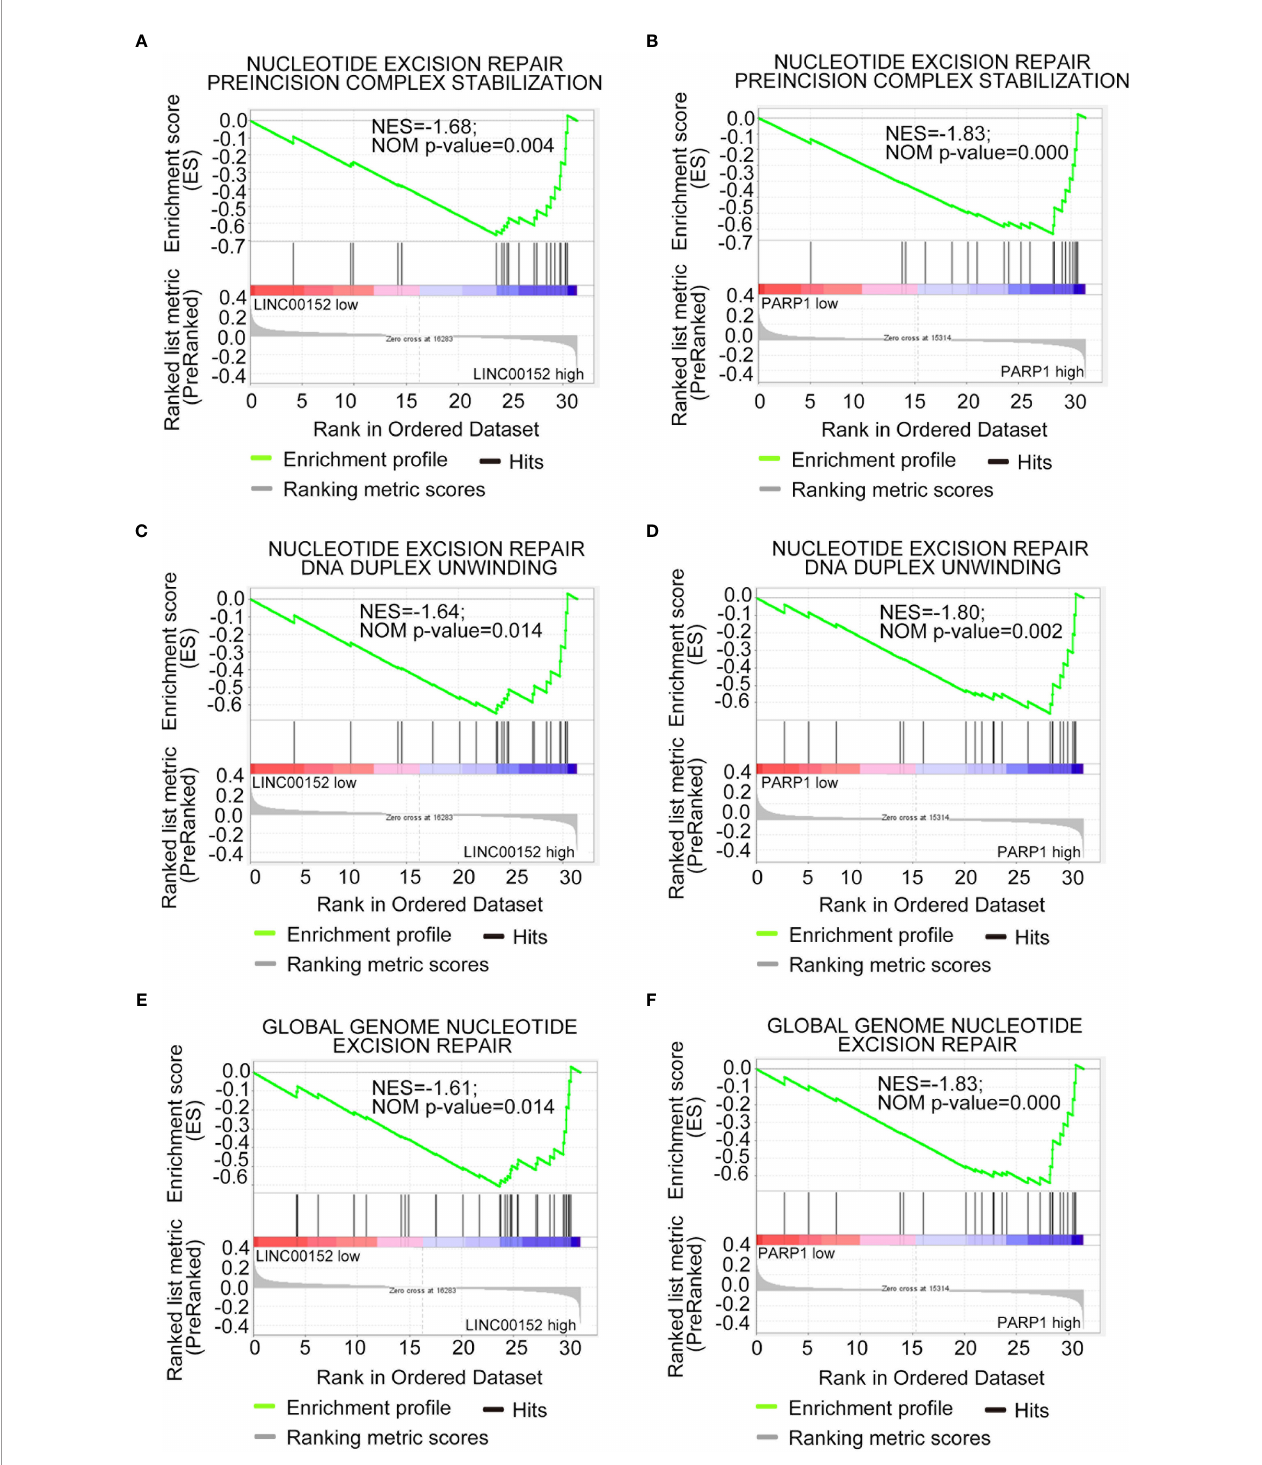
FIGURE 5 | Both LINC00152 and PARP1 expression correlated with DNA damage repair in acute myeloid leukemia. High expression of LINC00152 and PARP1 individually enriched the genes associated with nucleotide-excision repair, preincision complex stabilization (A, B) , nucleotide-excision repair, DNA duplex unwinding (C, D) , and global genome nucleotide-excision repair (E, F)